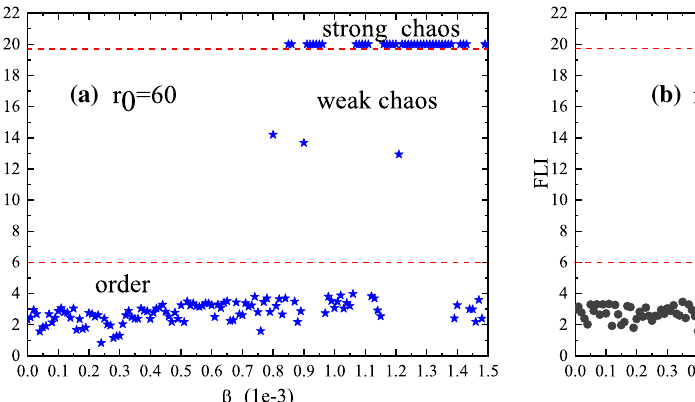
Fig. 5 Dependence of the values of FLIs on the magnetic parameter β . The other parameters are E = 0 . 995, L = 4 . 6 and a = 0 . 5. The initial conditions θ = π/ 2 and p r = 0 are the same in the two panels, but the